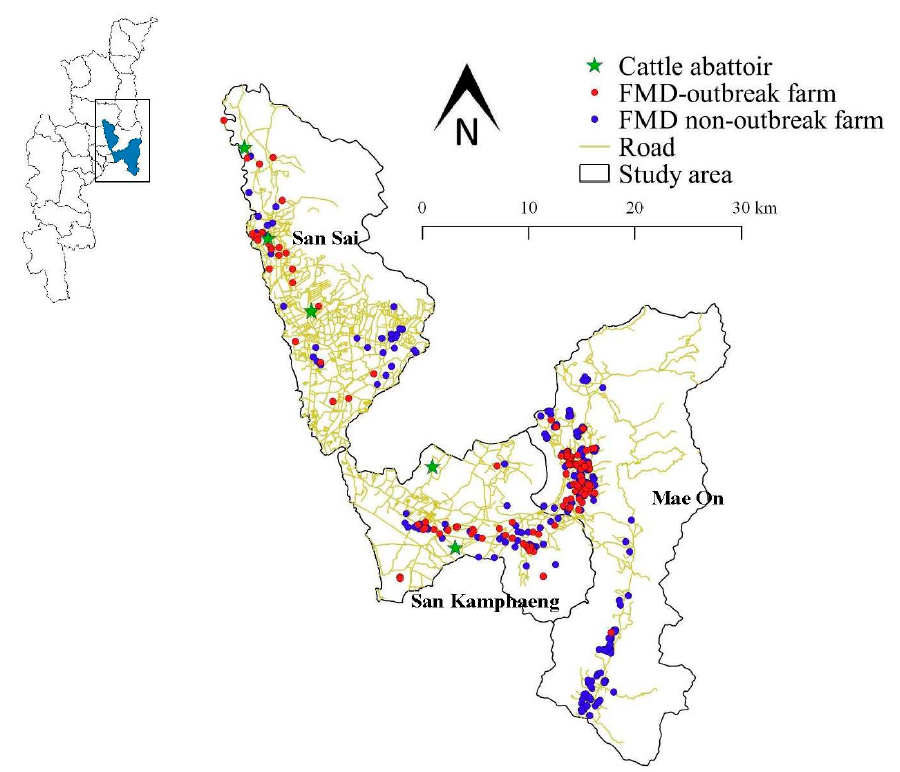
Figure 1. Location of foot and mouth disease (FMD) outbreak farms (red points), FMD non-outbreak farms (blue points), location of cattle abattoirs (green points) and roadways (gold lines) in 3 districts of Chiang Mai Province, northern Thailand.